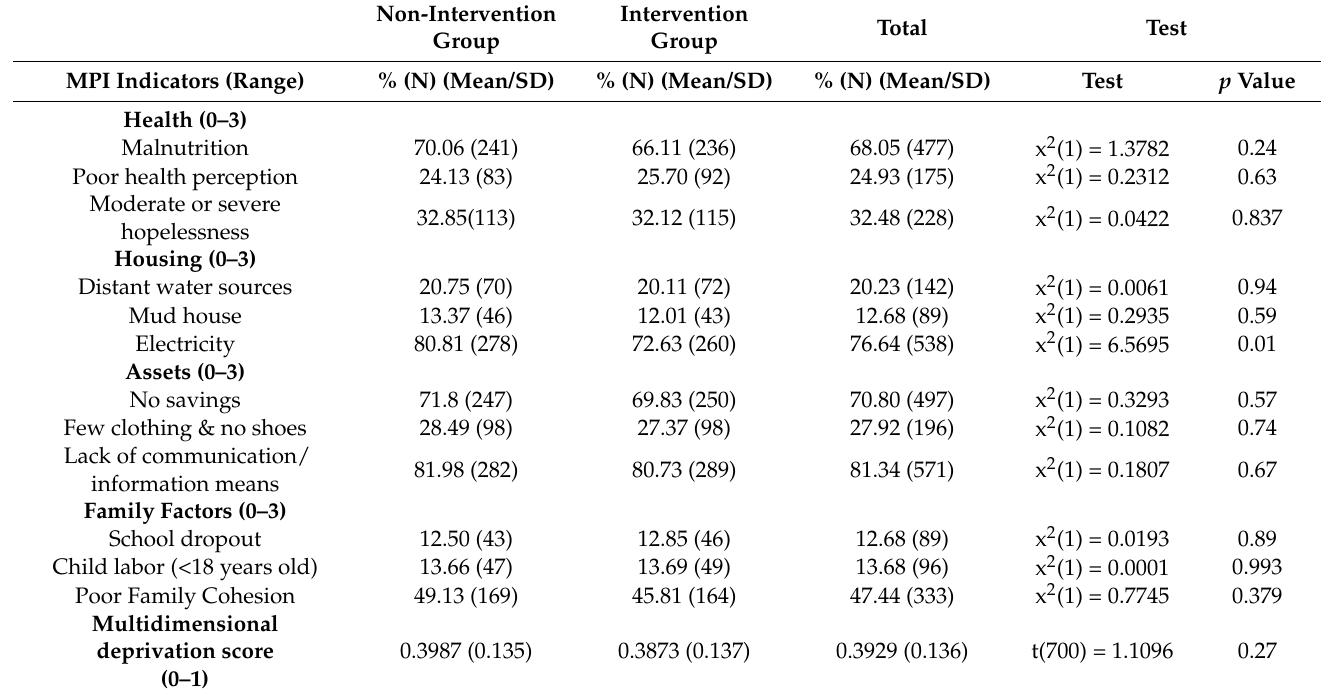
Table 3. Descriptive Data for deprivation in Multidimensional Poverty Index (MPI) Indicators at